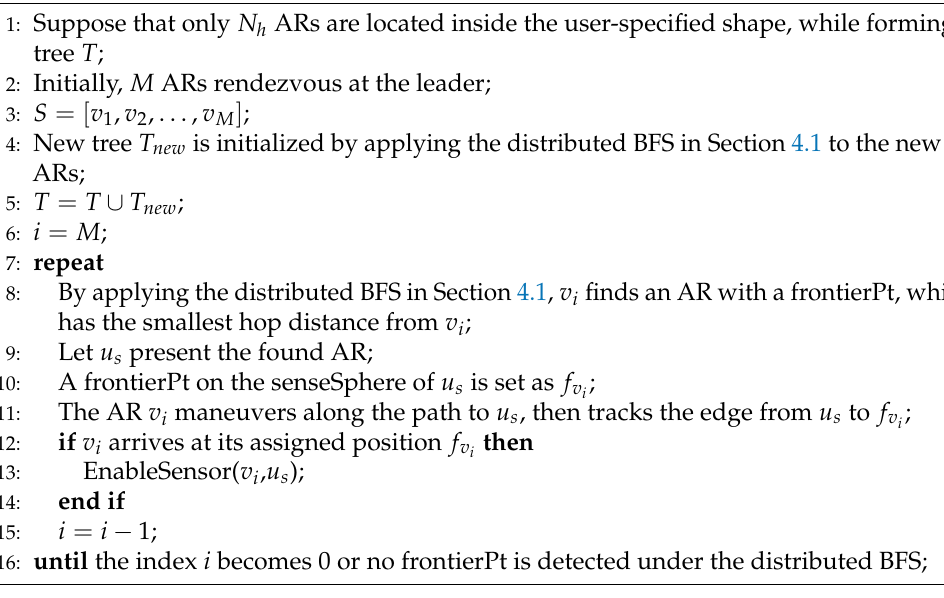
Algorithm 3 Cover the sensing holes